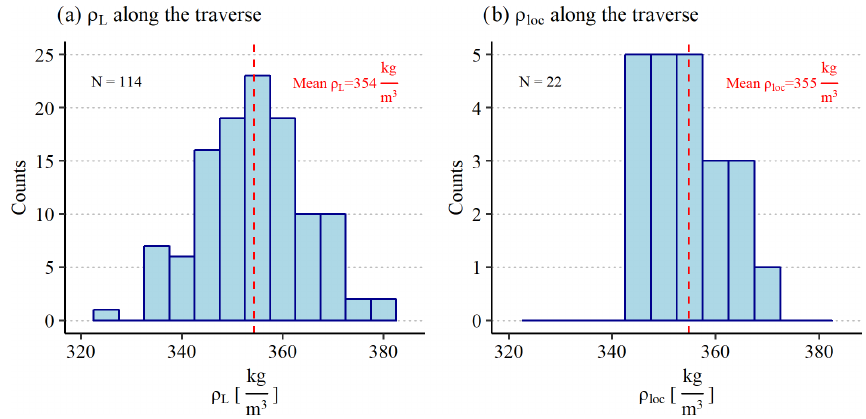
Figure 6. Histogram of (a) liner density ( ρ L ) and (b) location mean density ( ρ loc ) along the whole traverse route (profiles of the OIR trench not included). For both plots we used a bin width of 5kgm − 3 . The average liner density and location mean density, respectively, are shown by the red dashed line in (a) and (b) . Table 2. ρ loc at each location with multiple liners and the respective standard deviation. The number of liners at each location is given in brackets. For locations and abbreviations see Fig.